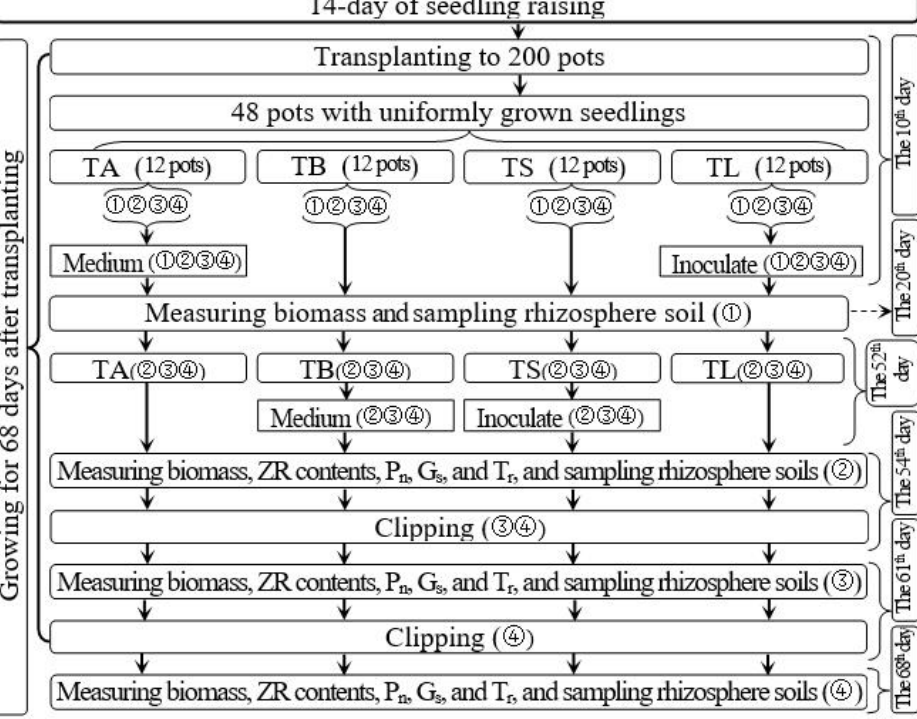
Figure 1. Schematic diagram for the experimental design. TA, TB, TS, TL indicate treatments of regrowth with liquid medium without AOB added relatively long before defoliation, regrowth with liquid medium without AOB added shortly before defoliation, regrowth with S2_8_1 strain inoculated relatively long before defoliation, and regrowth with S2_8_1 strain inoculated shortly before defoliation, respectively. “ ① ”, “ ② ”, “ ③ ”and “ ④ ” show the first, second, third and fourth subgroups of each treatment, respectively. The 10th, 20th, 52nd, 54th, 61st and 68th days refer to the 10th, 20th, 52nd, 54th, 61st and 68th of the 68 days after transplanting. ZR indicates zeatin riboside. P n , G s , and T r represent the net photosynthetic rate, stomatal conductance, and transpiration rate, respectively. From day 54 after transplanting to day 68 after transplanting, the 14-day regrowth period was selected. For inoculation of AOB, 200 mL of purified S2_8_1 culture (216,090 cfu · mL − 1 ) was added to the soils of TS and TL treatments on days 52 and 10 after trans- planting (on days 2 and 44 before defoliation), respectively. Meanwhile, 200 mL of liquid medium without AOB was added to the soils of TA and TB treatments on 52 and 10 days after transplanting (on days 2 and 44 before defoliation) as the control,